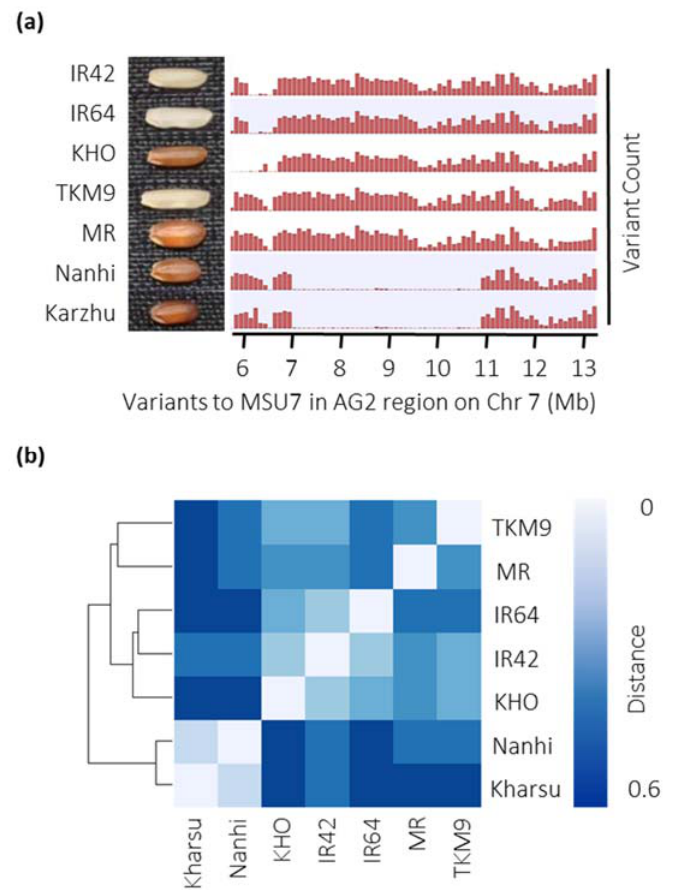
Figure 1. Sequence variation within AG2 region. ( a ) Sequence variants within the AG2 region (6 Mb to 13 Mb on chromosome 7) of AG donors (Nanhi Ma-Zhan Red (MR), Khao Hlan On (KHO), Kharshu 80A, and Nanhi) and AG susceptible varieties (IR64 and IR42) relative to Nipponbare. ( b ) Genetic distance (identity-by-state) matrix between AG donors and AG recipients based on variations within the AG2 region.